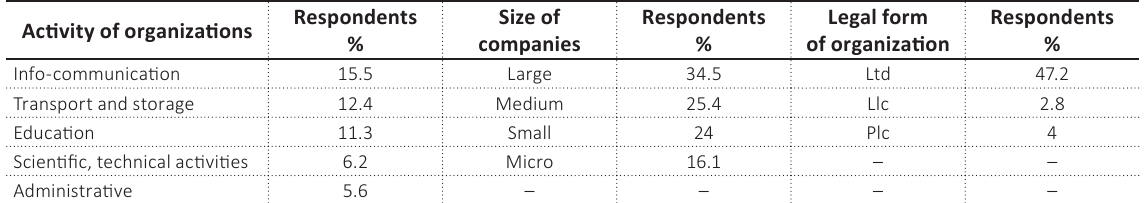
Table 3. Organizational characteristics